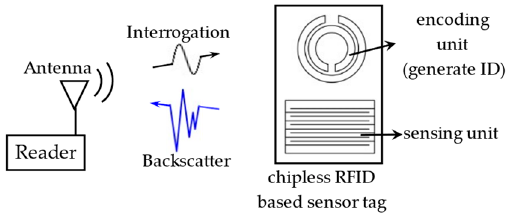
Figure 12. Block diagram of chipless RFID based sensor system.